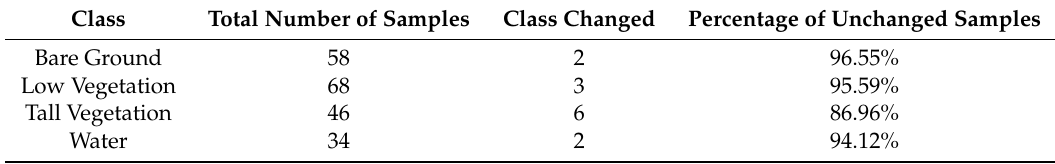
Table 2. Comparison of samples with class change based on accuracy assessment between Classification 2 and Classification 7 (without